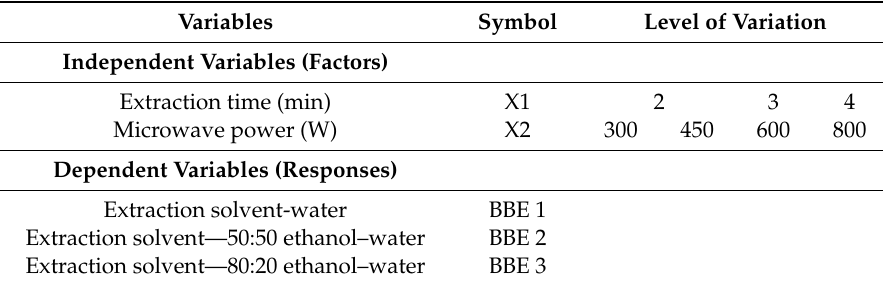
Table 1. Variables, symbols, and levels of variation used in the experimental